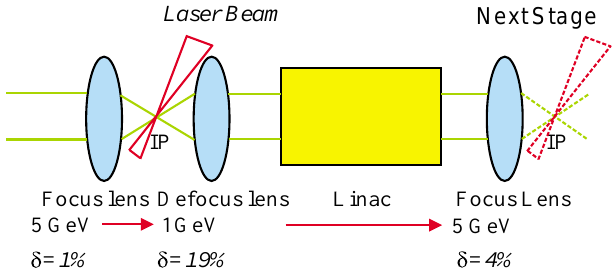
FIG. 8. (Color) Schematic diagram of the laser-Compton cool- ing of the electron